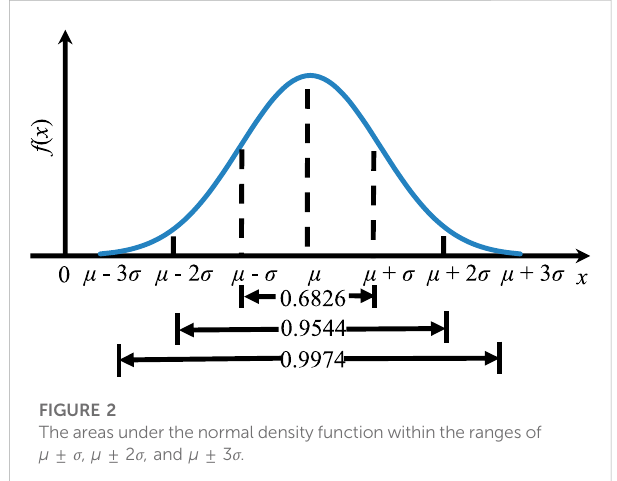
The areas under the normal density function within the ranges of μ ± σ , μ ± 2 σ , and μ ± 3 σ .